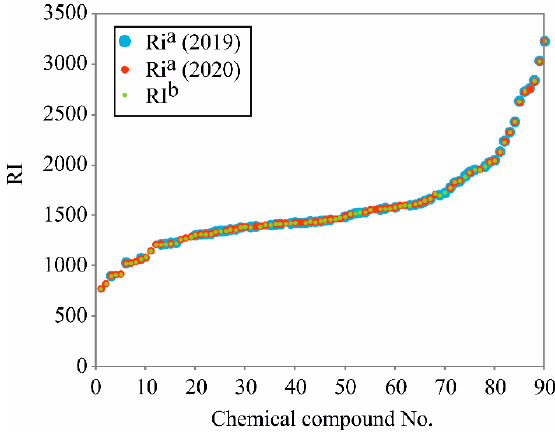
Figure 1. Retention indices (RIs) of the M. vulgare volatiles composition, from experimentally obtained GC–MS data on a HP-5MS column (RI a ) and NIST database (RI b ).